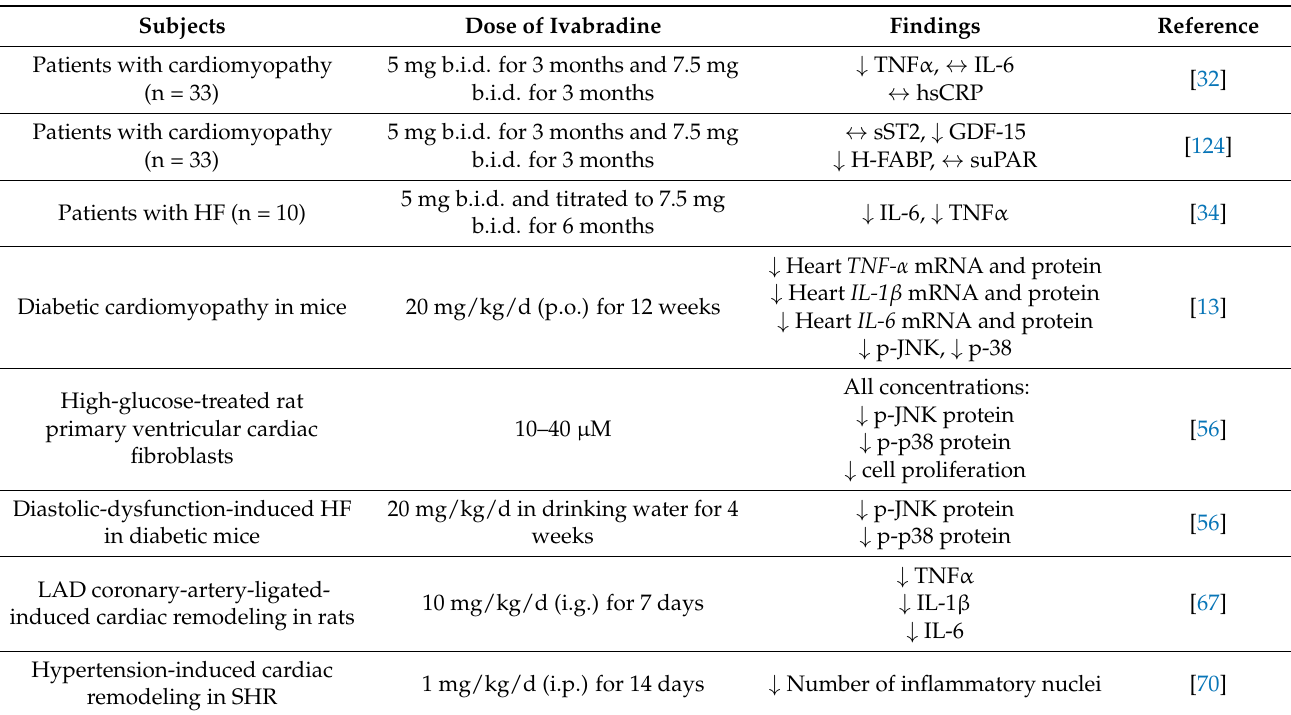
Table 7. Effects of ivabradine on inflammation and oxidative stress in patients with heart failure and animal